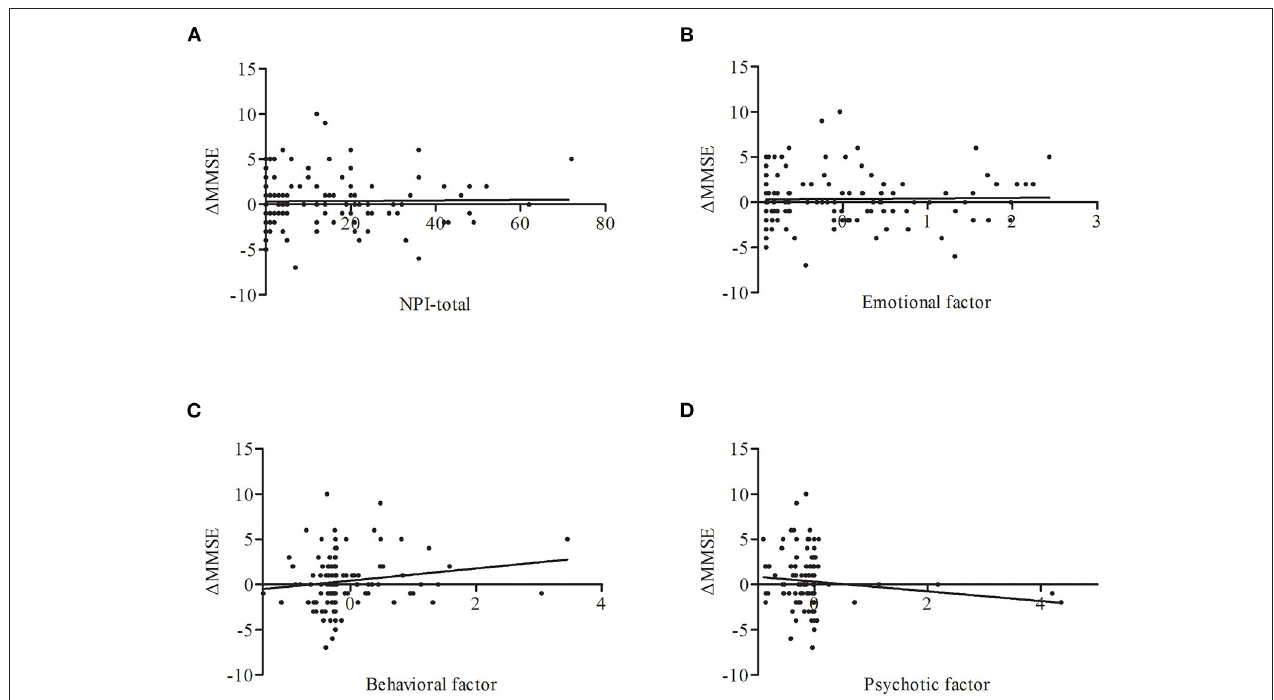
FIGURE 3 | Correlations between 1 MMSE and NPS including NPI-total (A) , emotional factor (B) , behavioral factor (C) , psychotic factor (D) across all subjects. Only behavioral factor on baseline has a trend to be correlated with the change of MMSE score ( r = 0.164, p = 0.051). 1 MMSE, MMSE score (baseline)-MMSE score (one year), adjust for age, sex, and education